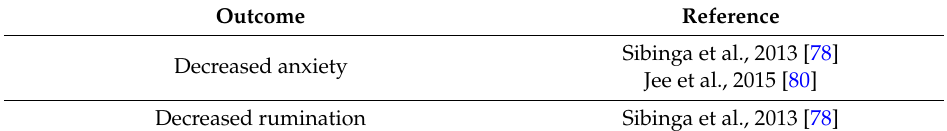
Table 1. Beneficial outcomes seen in research of mindfulness programs for children and